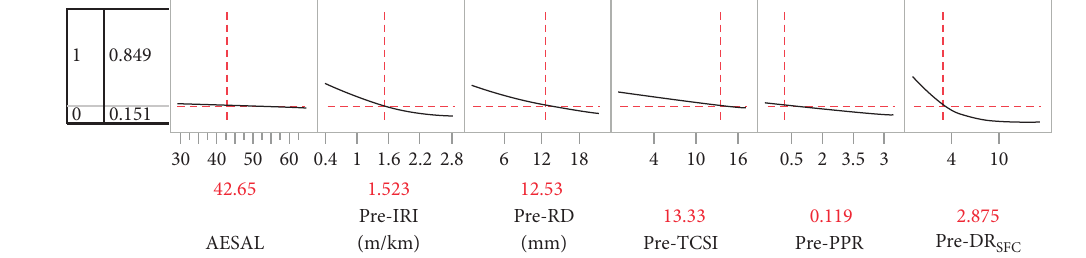
Figure 3: Prediction profiler.